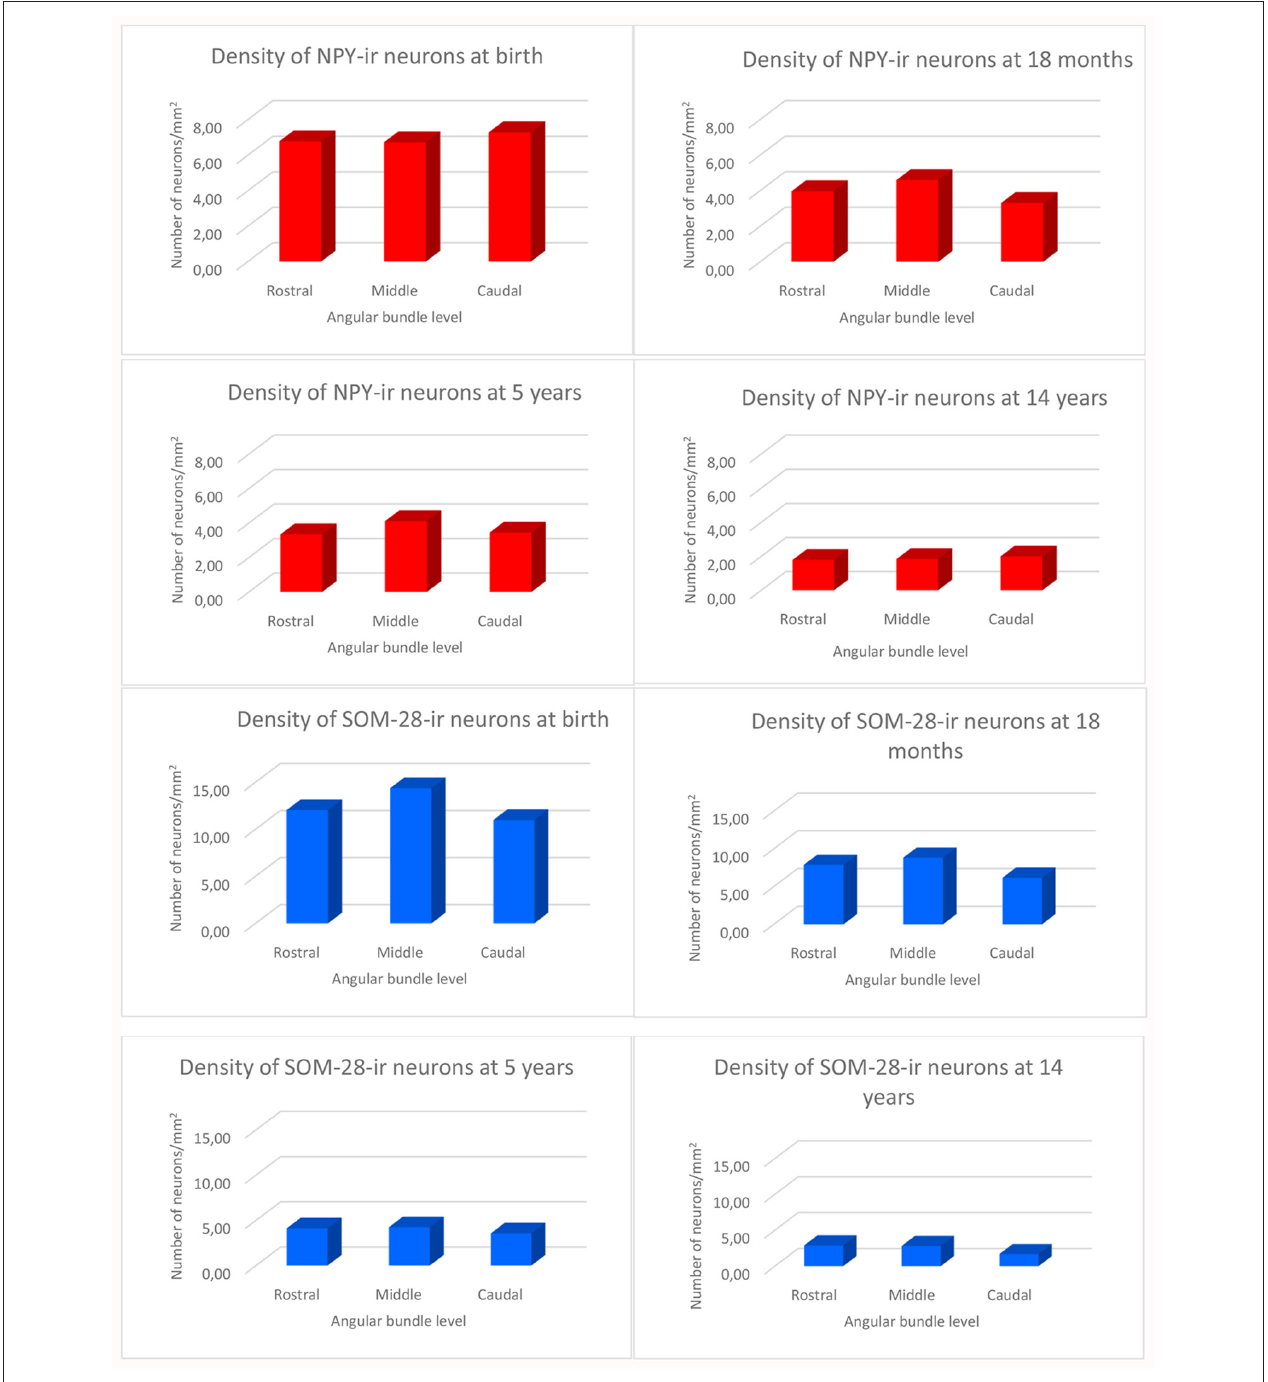
FIGURE 7 | Histograms showing the density of NPY and SOM-immunoreactive neurons per square millimeter distributed at three levels of the angular bundle: rostral, mid and caudal. Note the different scale for the number of labeled neurons used in NPY and SOM neuropeptides, respectively.